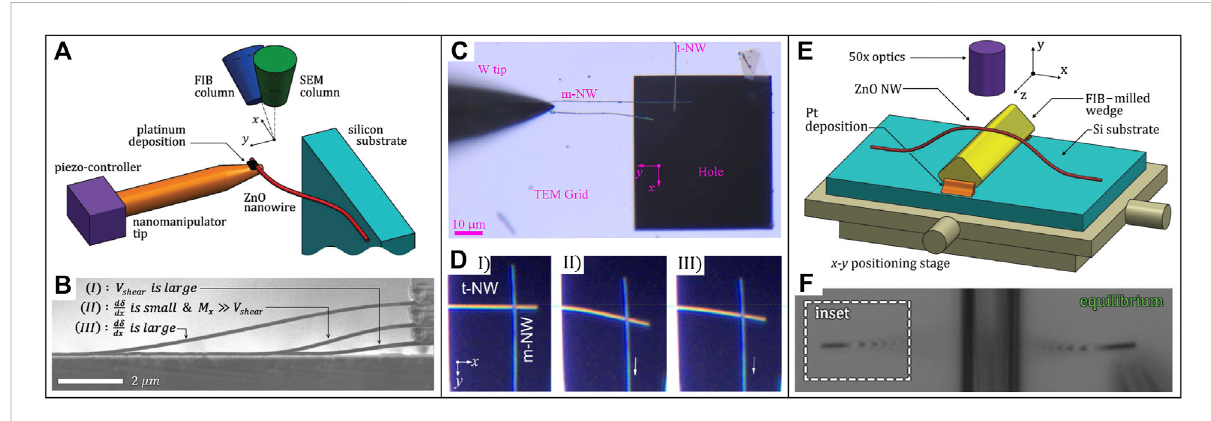
FIGURE 7 (A,B) ZnO NW peeling detection via SEM imaging-based read-out (Mead et al., 2018). (A) Schematic of setup. (B) Composite of 3x. SEM micrographsshowingpeelingprogression ofNW. (C,D) OMimaging-basedread-outofsliding SiCNWpair(Yibibulla etal.,2022).Micrographsof (C) experimental con fi guration, and (D) sliding progression, at stage I, II and III. (E,F) OM-based interferometric read-out of partially delaminated ZnO NW arch (Mead et al., 2020). (E) Schematic of experiment setup. (F) Micrograph show visible fringe patterns on suspended segment of